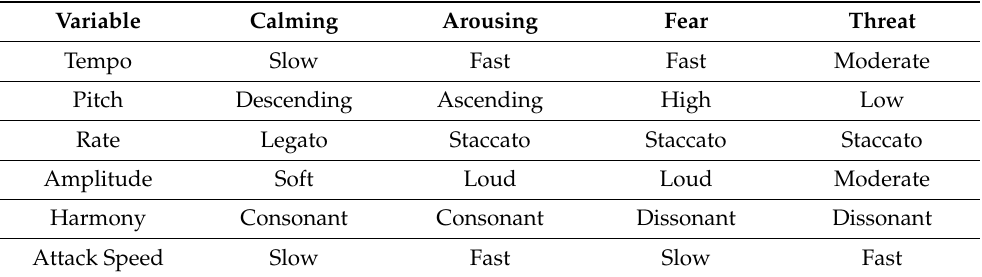
Table 2. How Music Conveys